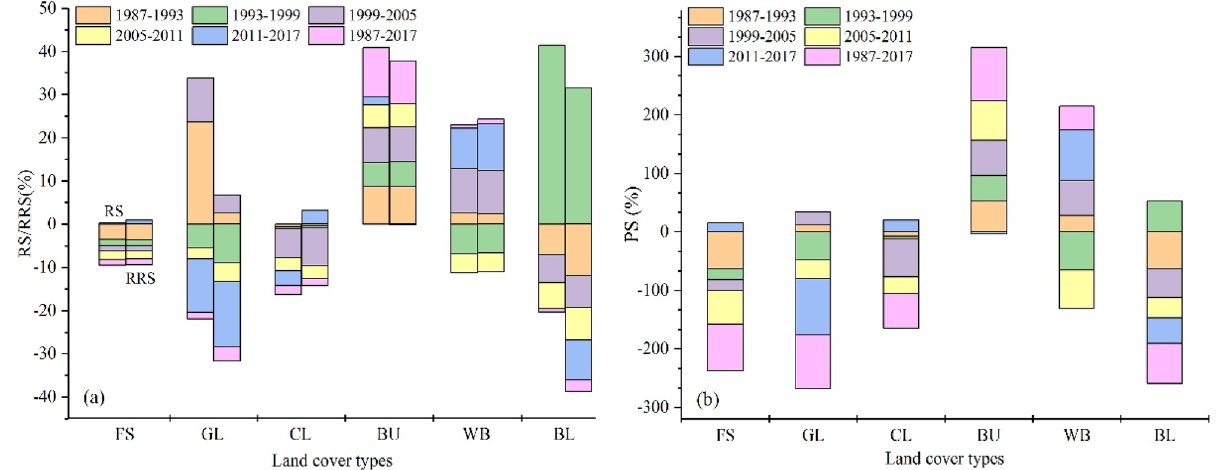
Figure 6. Change of each land cover type in different periods. FS, GL, CL, BU, WB and BL refer to forests, grassland, cultivated land, water bodies, built-up area and bare land, trivial. The change in dynamic degree and in the state index for forest areas both showed the trend of “increase– increase–decrease–increase”, indicating that the fluctuation in forest area in the study period had a trend of slowing down. The RSS of cultivated land increased from -0.48% between 1987 and 1993 to 3.18% between 2011 and 2017, indicating that cultivated land conversion was frequent and that the longitudinal change frequency was high between 2011 and 2017 and was stable between 1987 and 1993. The decrease in area of cultivated land was related to the gradual increase in the population’s demand for cultivated land, the low awareness of rational exploitation of resources and the modest awareness of the protection of cultivated land in recent years. From 2011 to 2017, the RSS and PS values of water body areas both increased significantly, indicating the frequent spatial changes in water body areas. This was significantly related to the gradual improvement of the ecological water supply system in the main urban area of Guangzhou, the increasing awareness of water resource conserva- tion and protection and the strong water resource management system. To sum up, these characteristics were in good agreement with the above phenomenon (Fig. 5). Spatial change of LULC based on grids. To clearly show the spatial changes of different LULC types from 1987 to 2017, the ArcGIS spatial statistics tool was used to calculate the grid-based change intensity. Here, the change map of each LULC type was subdivided into non-overlapping blocks of 0.5 km × 0.5 km, and the statistical information of land use change information in each grid was calculated (Fig. 7). The forest area in the Tianhe district and the Baiyun district decreased significantly (Fig. 7a), while the grassland change was not remarkable (Fig. 7b) and the cultivated land area in the northwest part of the Baiyun district showed a significant decrease (Fig. 7c). According to the change intensity chart, the main process of LULC change was the conversion between cultivated land, forest area and built-up area. Hotspots with shrinking forest and cultivated land were seriously threatened by the expansion of built-up areas (Fig. 7d). Water body and bare land areas did not change signifi- cantly (Fig. 7c,d). During the study period, the serious decrease in natural vegetation coupled with the decrease in the cultivated land ecosystem highlighted the serious decrease in important ecological categories of LUCC and the corresponding increase in production-oriented land use in the main urban area of Guangzhou. This means that human encroachment into the natural ecosystem increased.